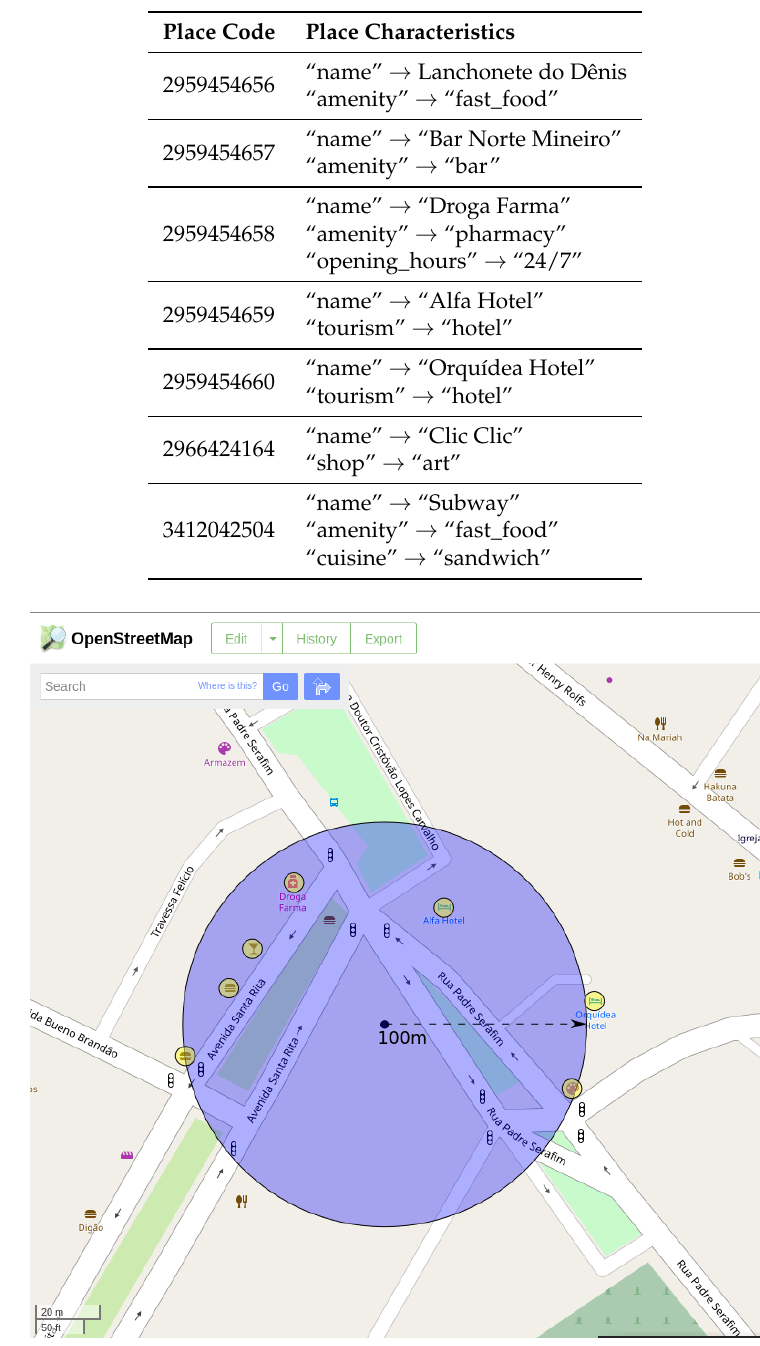
Figure 2. Example of a contribution semantically enriched by the proposed algorithm using